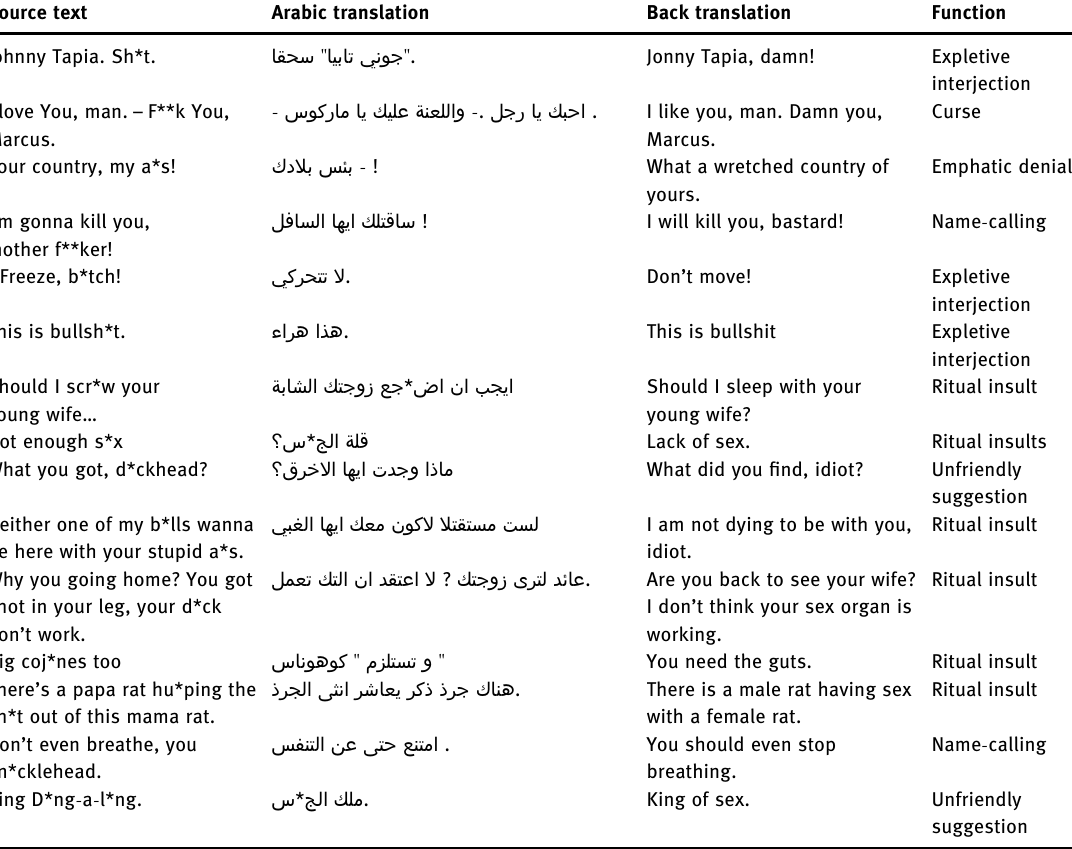
Table 13: Standalone – swearing Source